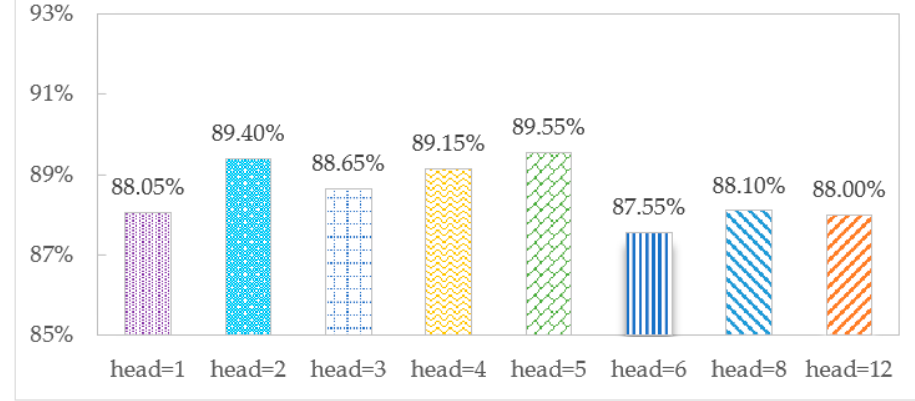
Table 5. Experimental results of removing temporal convolutional network .